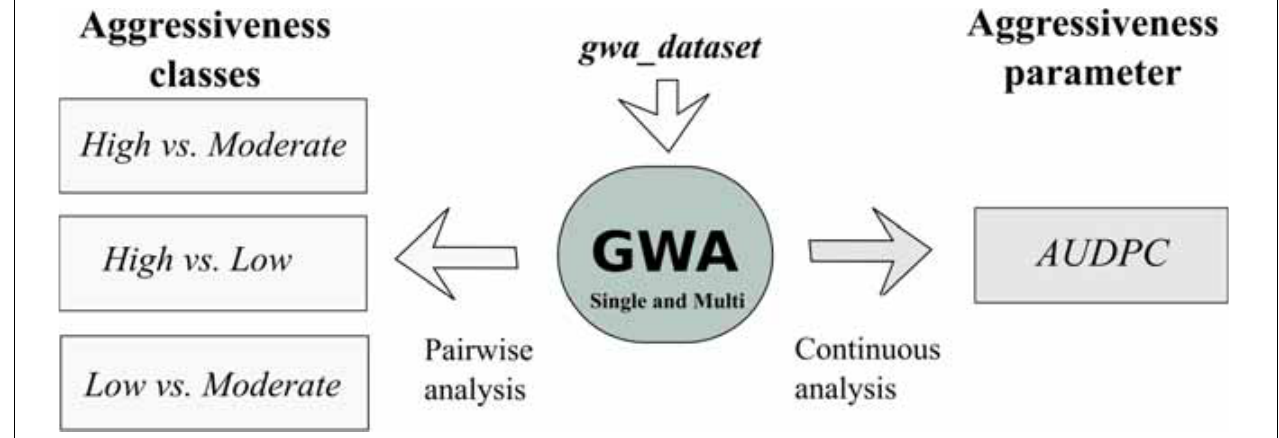
FIGURE 2 | Schematic representation of the dataset and GWA analyses conducted in this study. The pairwise analysis was performed taking into account the aggressiveness classes ( High , Moderate , Low ) previously described by Vieira et al. (2018), and the continuous analysis was performed with the AUDPC values obtained by Vieira et al.